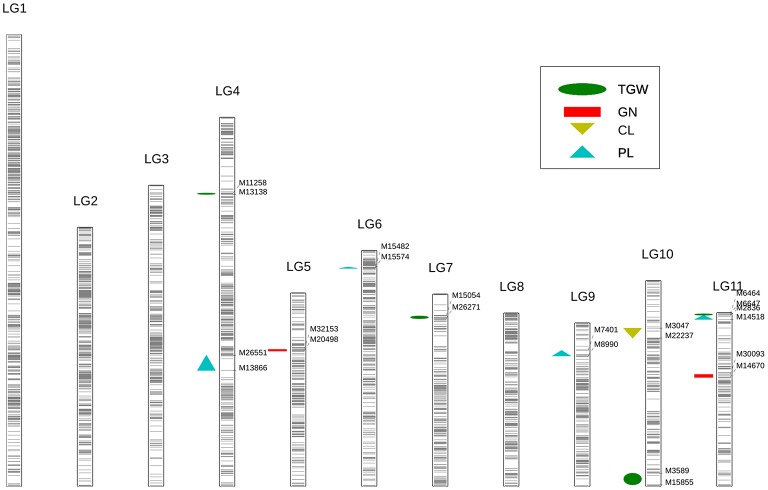
Identification of yield-related QTL using high-density genetic map in cowpea. Each black line represents a SNP locus. The green ellipse represents the trait of thousand-grain weight (TGW); the red rectangle represents the trait of grain number per pod (GN); the yellow triangle represents the trait of carpopodium length (CL); the blue triangle represents the trait of pod length (PL).